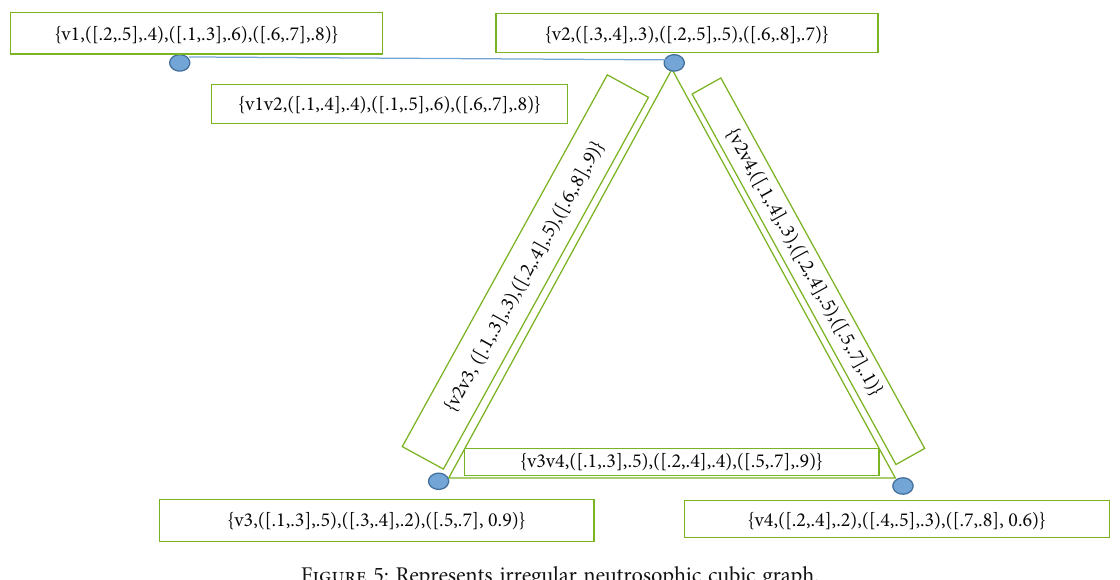
Figure 5: Represents irregular neutrosophic cubic graph.